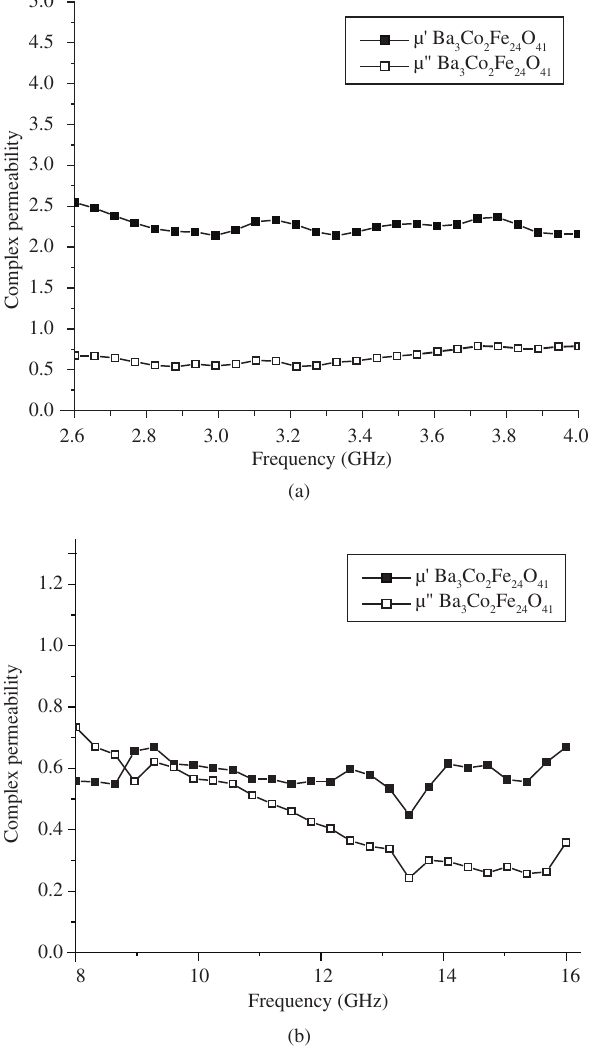
Figure 7. Complex permittivity ( ε * ) as a function of frequency (GHz) for (for Ba Co Fe O /CR composites (80/20, wt. (%)), ( ■ real) and x ( □ imaginary): 3 2 24 41 a) S-band and b) X-kU